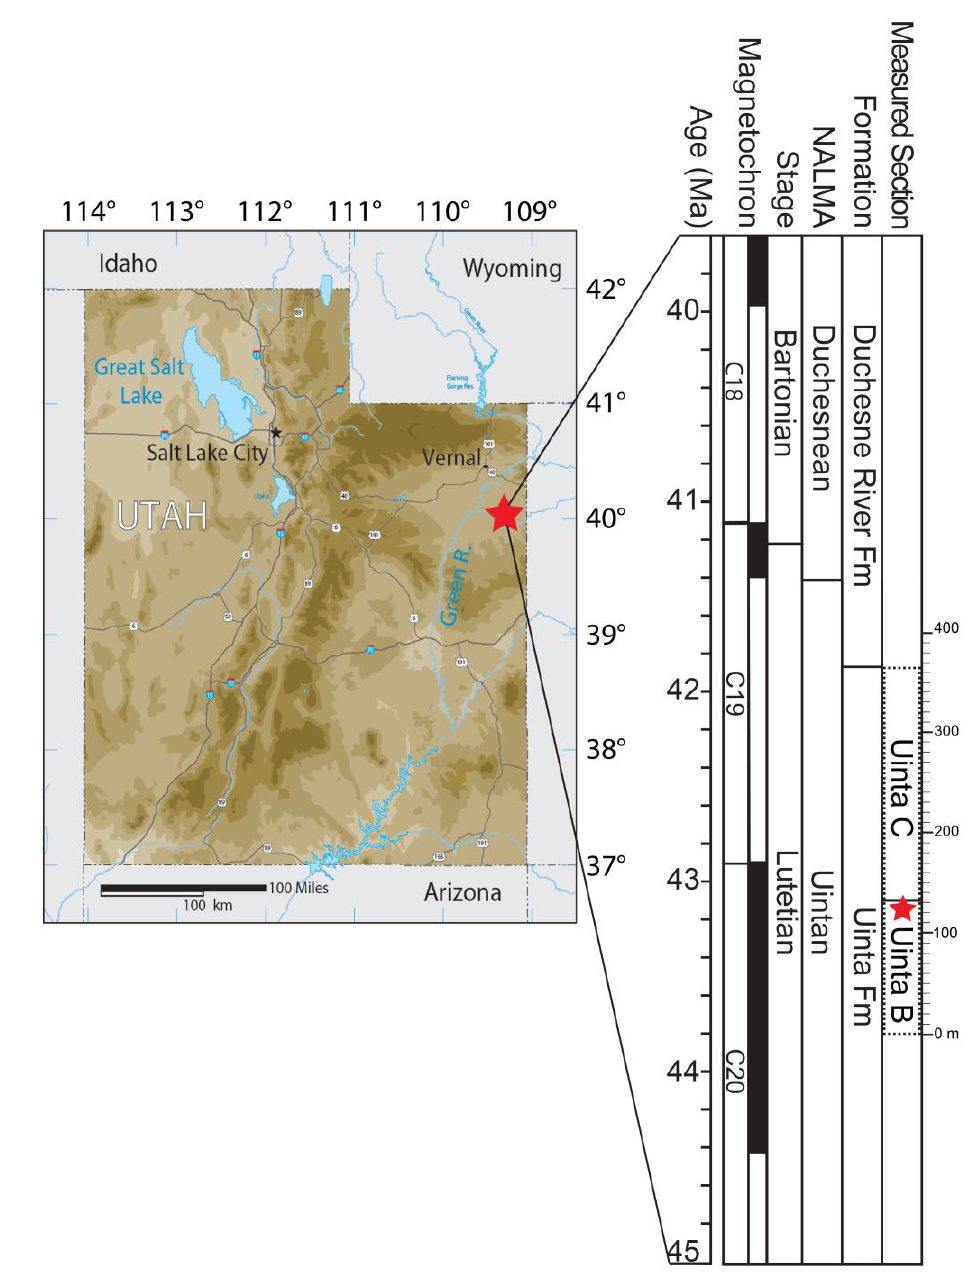
Figure 2. Geographic and stratigraphic position and correlation of the fossil locality (UMNH.VP.LOC 2734) of the Uintan paraortygid. The dotted lines represent the position of the measured stratigraphic section from Townsend et al. [26] relative to the Global Magnetic Polarity Time Scale based on correlation with the magnetostratigraphic section of Townsend et al. [27] and Prothero [28]. The red star indicates the position of UMNH.VP.LOC 2734 at 123 m within the measured section and on the map.